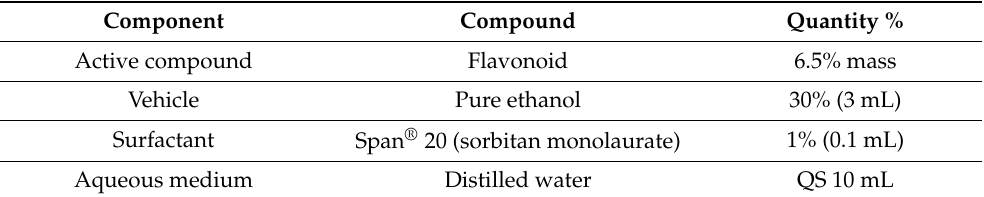
Table 2. Composition of a hydroalcoholic solution of flavonoid (6.5% mass). Component